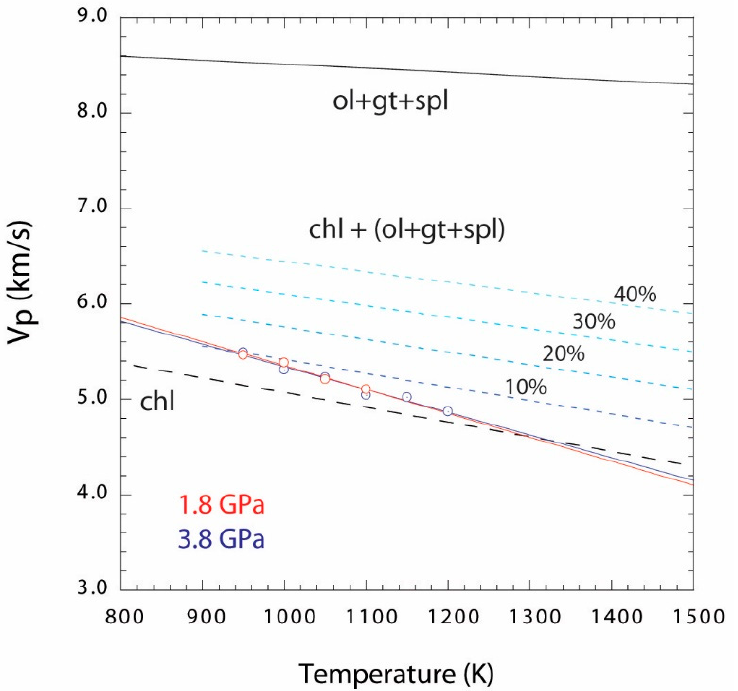
Figure 4. P-wave velocity compared with the vol.% of chlorite dehydration. The Vp vs. temperature diagram showing the P-wave velocity for chlorite and dehydration products. The black dashed line indicates the Vp of chlorite before dehydration, extrapolated to high temperatures. The purple solid line indicates the P-wave velocity of a mixture of olivine [47], garnet [48], and spinel [49], computed for 3:1:1 proportion based on the dehydration reaction 2chl = 3ol + gt + spl + 8 H 2 O. Blue dashed lines indicate the linear mix between the velocity of chlorite and the (3ol + gt + spl) without taking into account the velocity effect of fluid. The numbers next to dashed lines indicate the fraction chlorite dehydrated producing the (ol + gt + spl). The red and blue solid lines indicate linear fits through the Vp data points of chlorite measured at 1.8 and 3.8 GPa, respectively.